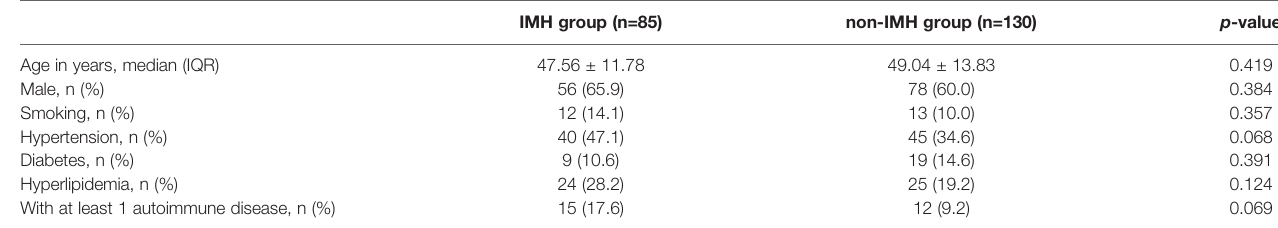
TABLE 3 | Characteristics in patients with and without